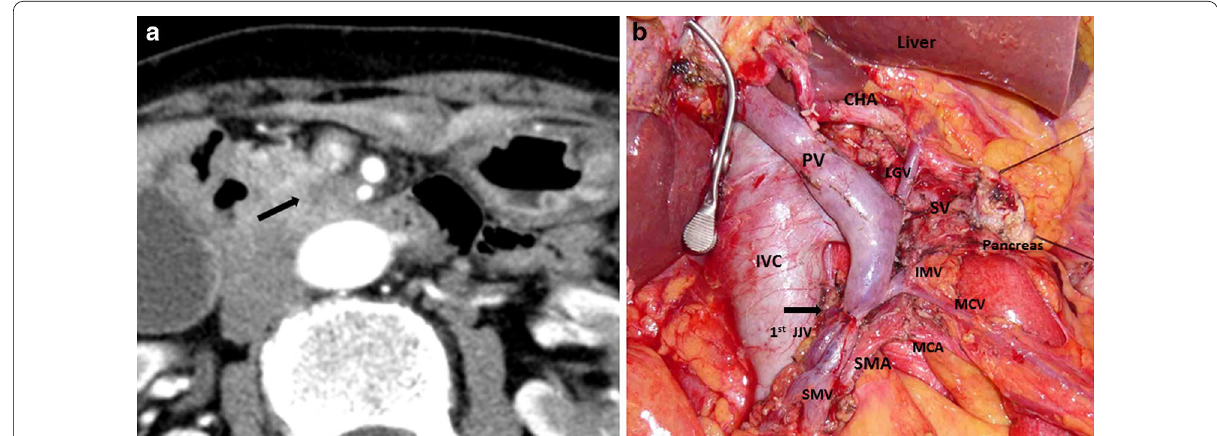
Fig. 1 a Contrast-enhanced computed tomography (CECT) scan showing a hypovascular tumor abutting the superior mesenteric artery (SMA) and involving < 180° of the circumference of the artery without encasement. b Intraoperative photographs. The black arrowhead shows the anastomosis of the superior mesenteric vein with the 1 st jejunal vein. SMA: superior mesenteric artery. SMV: superior mesenteric vein. 1st JJV: 1st jejunal vein. PV: portal vein. MCA: middle colic artery. MCV: middle colic vein. IMV: inferior mesenteric vein. SV: splenic vein. LGV: left gastric vein. IVC: inferior vena